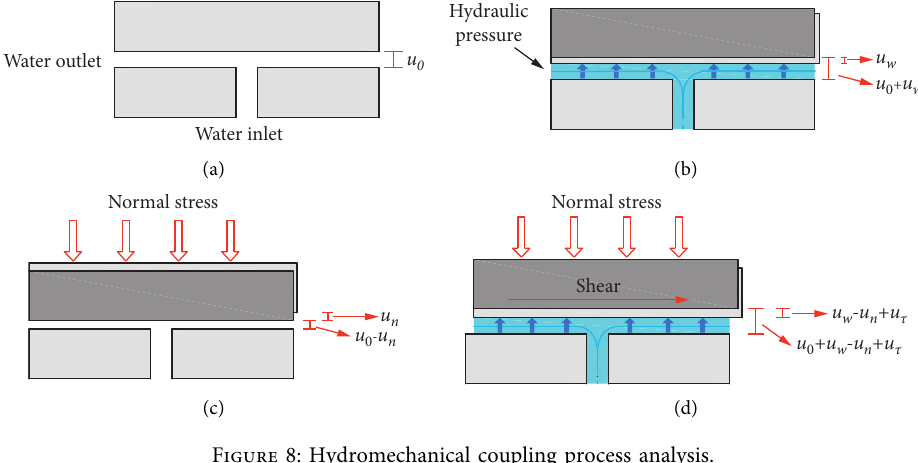
Figure 8: Hydromechanical coupling process analysis.